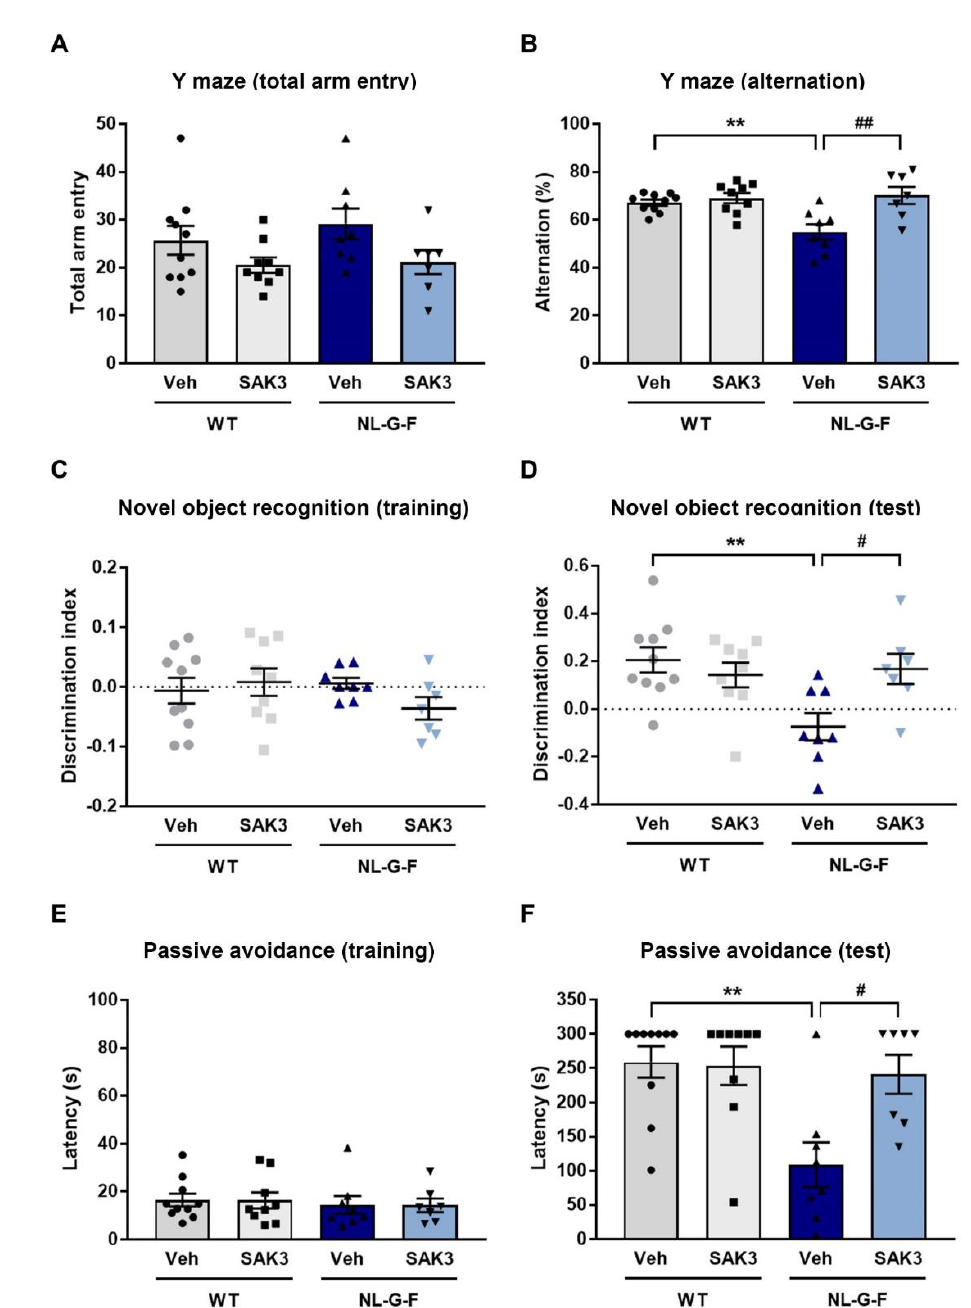
Figure 6. SAK3 administration ameliorates cognitive deficits in NL-G-F mice. ( A ) Number of total arm entries and ( B ) alternations in a Y-maze task ( n = 7–10 per group). F (3, 30) = 7.678, p < 0.01. Discrimination index of object exploration during ( C ) the training session and ( D ) the test session in a novel object recognition task ( n = 7–10 per group). F (3, 30) = 4.98, p < 0.01. Latency to enter the dark compartment in ( E ) the training session and ( F ) the test session of the step-through passive avoidance task ( n = 7–10 per group). F (3, 30) = 6.425, p < 0.01. Error bars represent SEM. ** p < 0.01 vs. vehicle-treated WT mice; # p < 0.05, ## p < 0.01 vs. vehicle-treated NL-G-F mice. The symbols (solid dots, squares, triangles and inverted triangle) indicate the individual values.